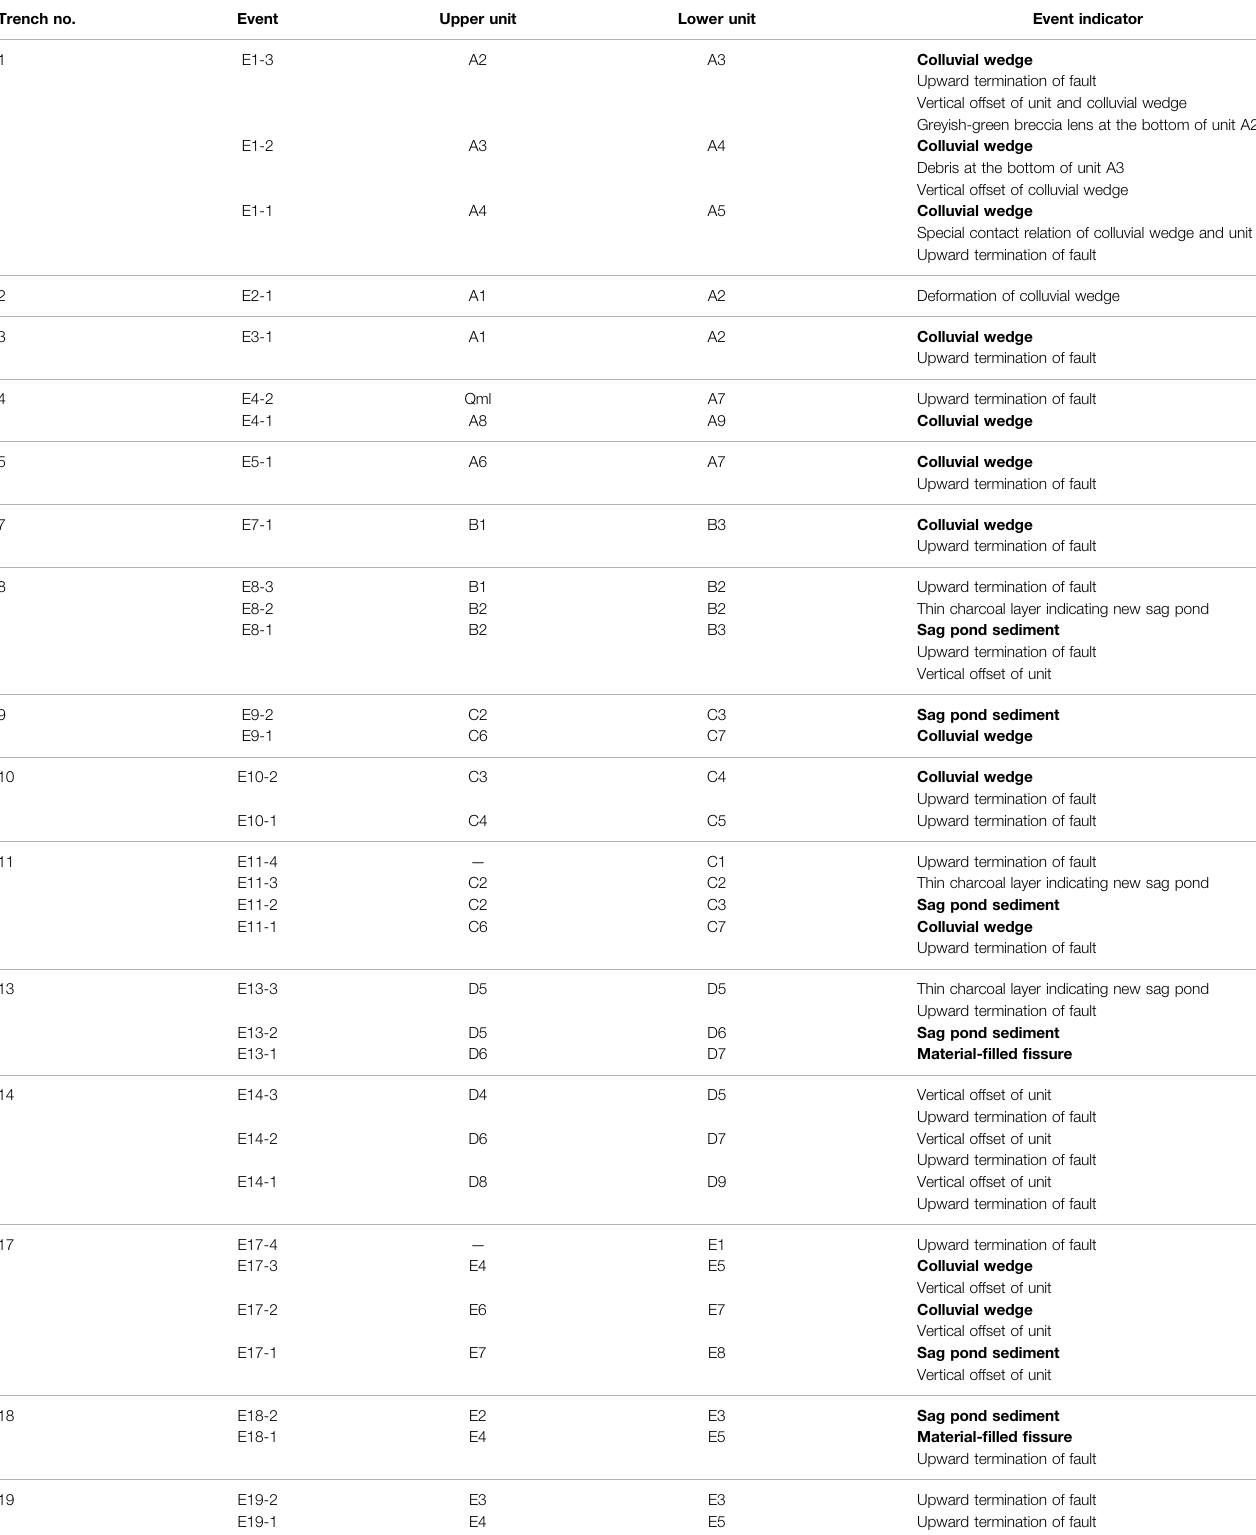
Bold event indicators are the indicators of high